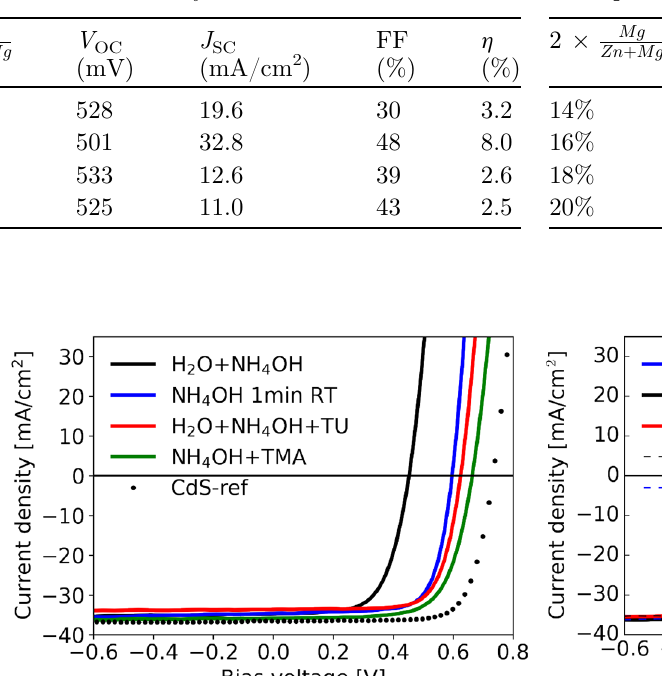
Table 1. PV parameters of devices with KCN only surface treatment, see Figure 2a. Percentages correspond to the Mg content of the buffer layer.